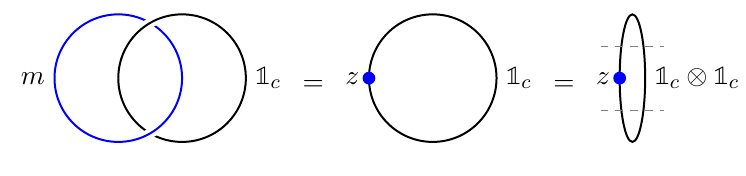
Figure 19. An m - 1 c -link is equal to the composition of three 0d domain walls.